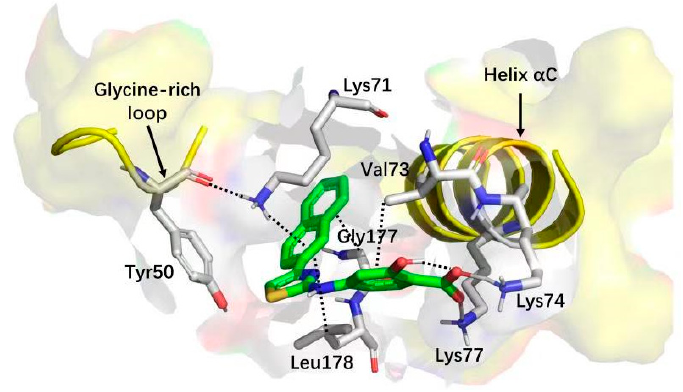
Figure 7. Cartoon/surface representation of the interaction between 15 with the G-loop and α C-helix.